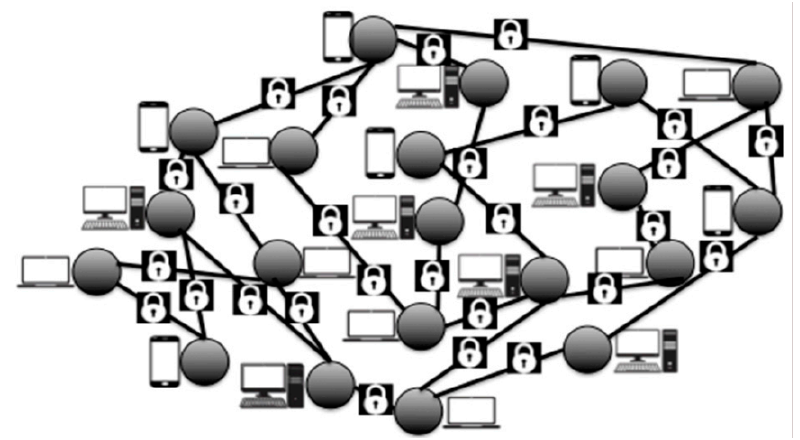
Figure 3. Private